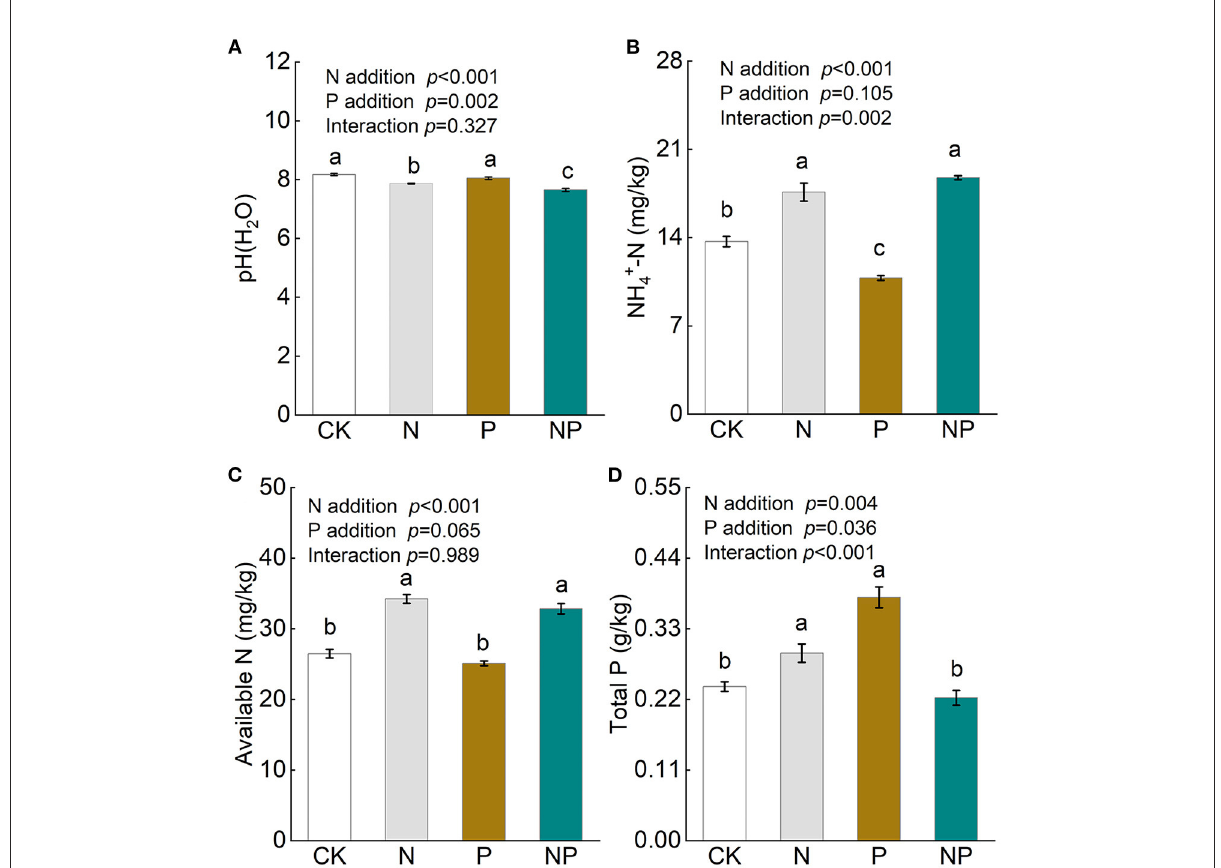
FIGURE1 The variation of soil pH (A) , soil NH + 4 -N (B) , soil available N (C) , and soil total P (D) under different nutrient additions. Values are means with SE ( n = 4). Different lowercase letters represent significant difference among treatments determined by LSD-test ( P = 0.05). CK, the control; N, nitrogen addition; P, phosphorous addition; NP, the combined addition of nitrogen and